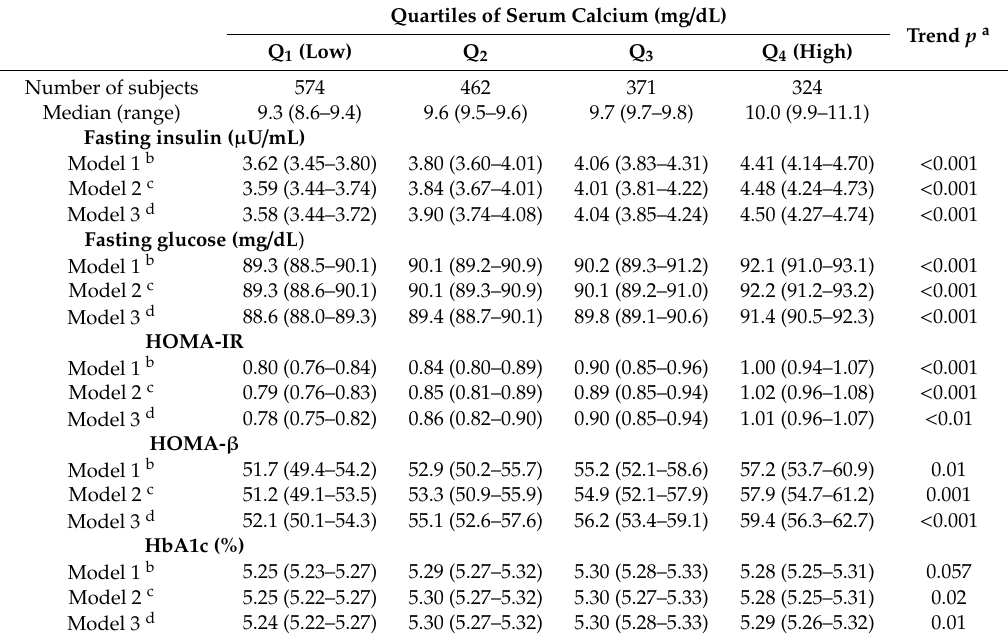
Table 2. Adjusted means (95% CI) of insulin, glucose, HOMA-IR, HOMA- β , and HbA1c across quartiles of serum